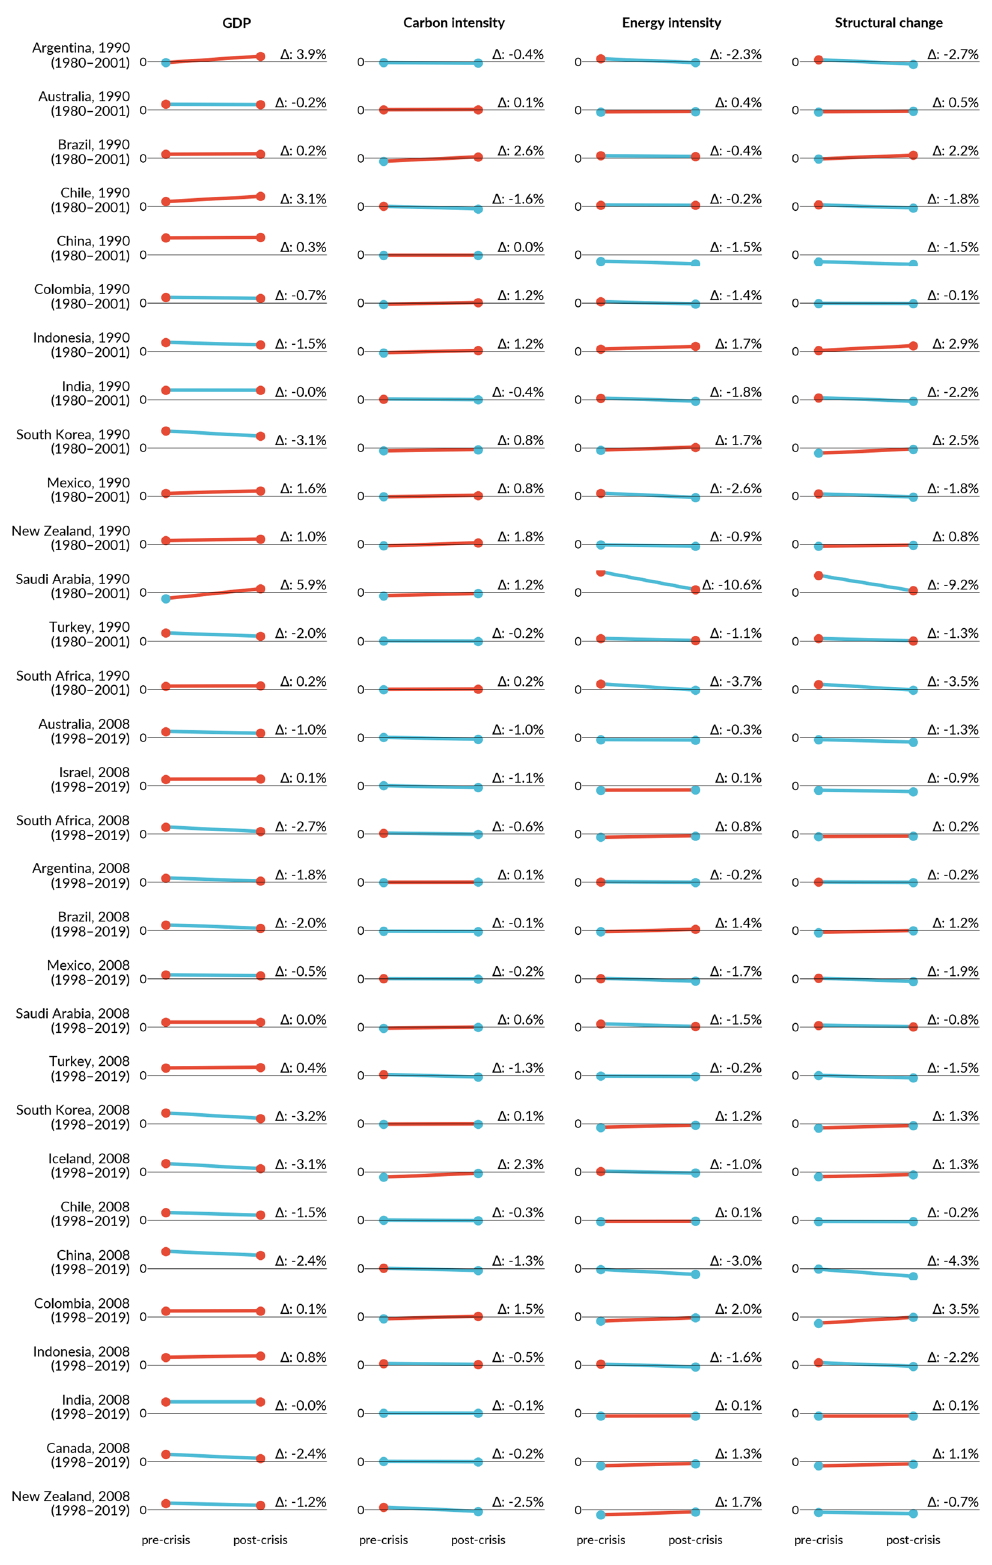
Fig. 5 Decomposition of CO 2 emission drivers in non-peaking countries following the GFC and Soviet crisis. Changes in growth rates (% per year) of contribution factors to carbon emissions before ( fi rst point) and during and after (last point) the economic crisis associated to the CO 2 peak, based on the Kaya identity and multiplicative decomposition. GDP includes population and GDP per capita factors. Structural change is the change of combined energy and carbon intensity factors. Red (blue) circles mean that the factor increased (reduced) emissions; red (blue) lines indicate that the change from pre- to post-crisis was negative (positive) for decarbonisation. The year after the country name denotes the fi rst year of crisis and the period below the country name denotes the entire analyses period. Time series fi gures for the GFC in Supplementary Note 7. Source: 31,32,57 .